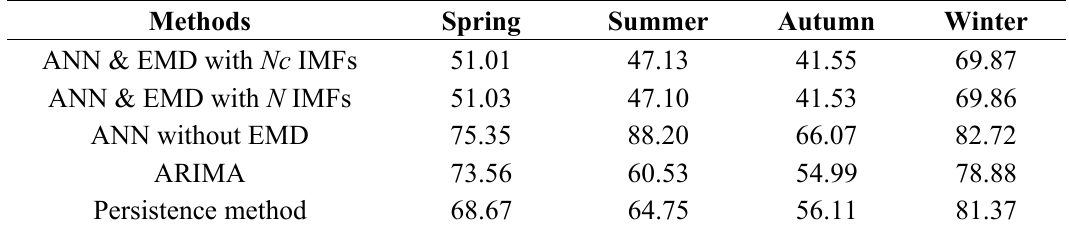
Table 7. RMSE of forecasted wind power (kW) obtained by various methods.